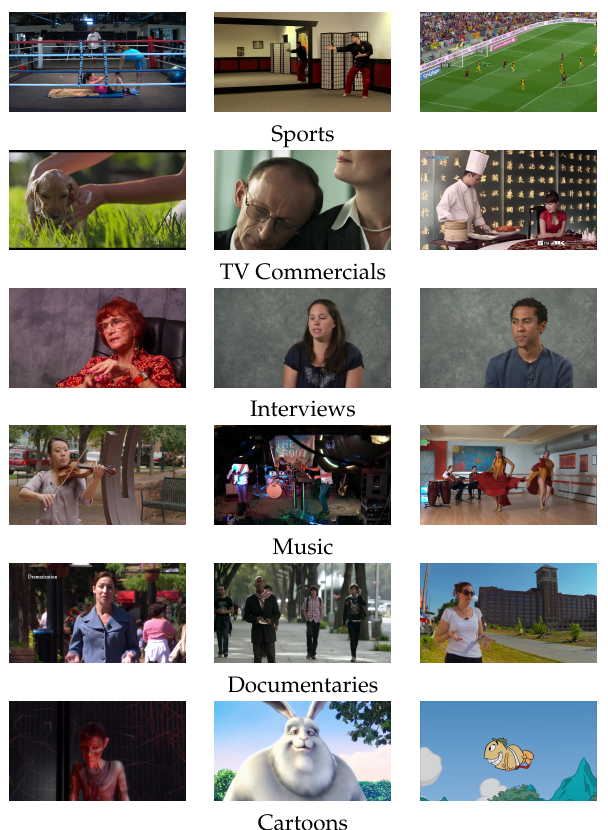
Figure 1. Sample frames of the videos from the UnB-AV Database. The database include different genres contents like: Sports, TV Commercials, Interviews, Music, Documentaries, and Cartoons